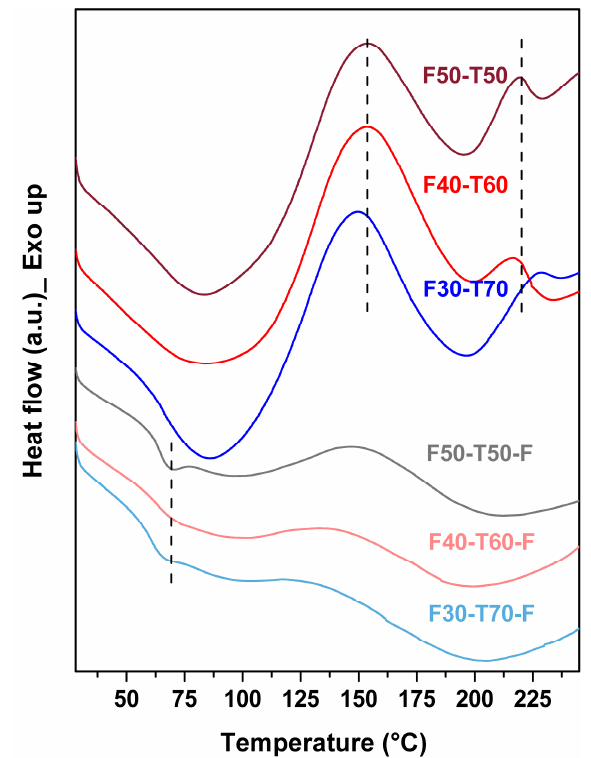
Figure 5. DSC (differential scanning calorimetry) plots of powder and film samples (first heating scans): dash lines in powder samples indicate the exothermic transitions at 153 and 220 °C and the dash line in film samples indicate T g at 69 °C.